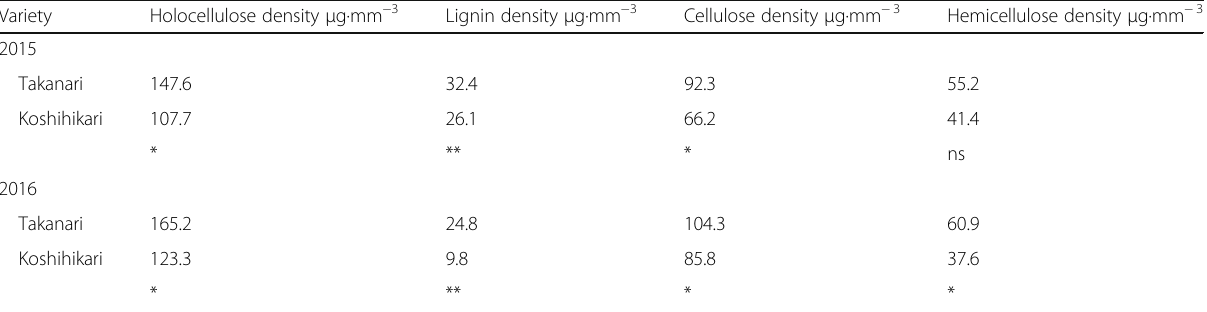
Table 2 Cell wall material density of Koshikari and Takanari in 2015 and 2016